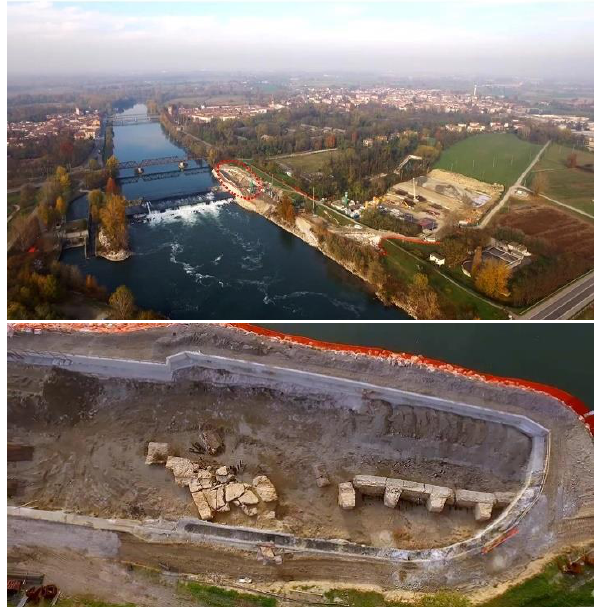
Figure 3. Above: aerial view of the area of the hydroelectric plant. Below: the archaeological structures on the Adda river. The structure is poorly preserved, and consists of its northern part, including: the north wall, with the presence of two deep vertical “grooves” and a small portion of the southern wall with equal characteristics. Between the two wall structures, a floor was preserved, made of bricks placed in a herringbone pattern, and covered by a homogeneous mortar layer, characterized by the presence of a series of quadrangular and shallow holes and channels. These elements represent the parts to house all the necessary tools to control and use the water as the driving force of the mill; the absence of these mechanisms is due to their reuse in new mill built at the start of the XIX century. Along the west front of the structures, wooden poles were found deeply driven into the ground with double function: to stabilize the massive structures of the mill and to contain the erosive action of the river. Moreover, the poles placed more externally had to be connected with a pier for mooring of boats that sailed on the river.